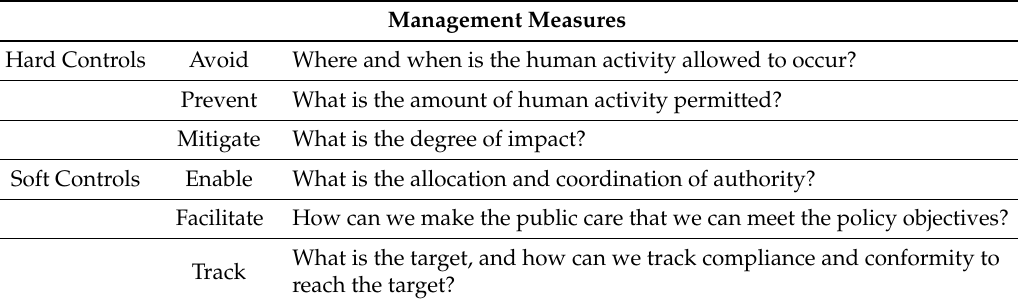
Table 2. System of management measures (adapted from [78] and illustrated in [40]).